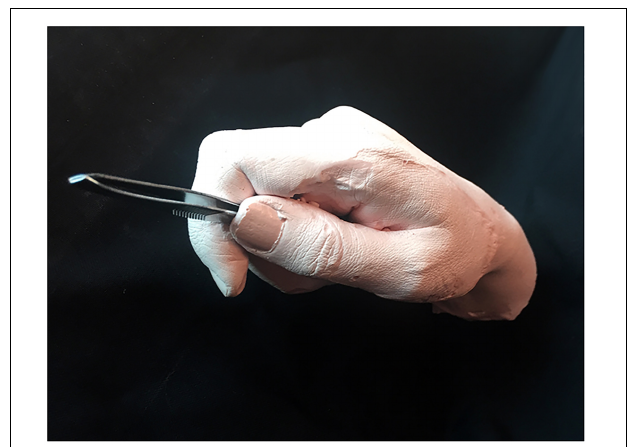
FIGURE 6 | The life cast of a hand holding tweezers. The tweezers measured 9 cm in length.